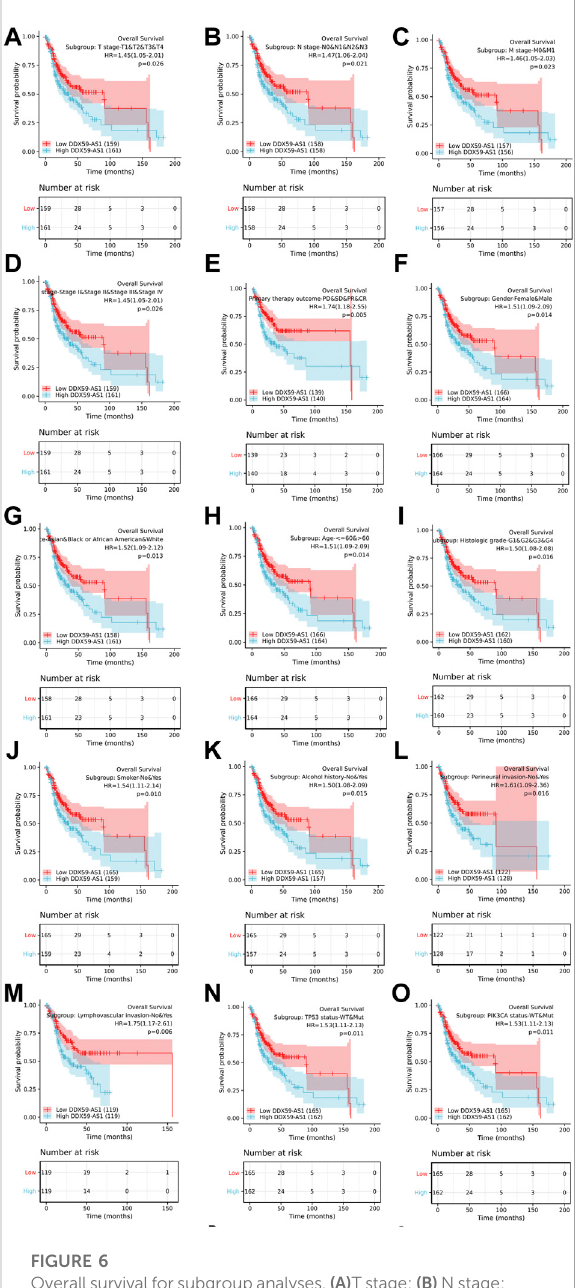
FIGURE 6 Overallsurvivalforsubgroupanalyses. (A) Tstage; (B) Nstage; (C) M stage; (D) Clinical stage; (E) Primary therapy outcome; (F) Gender; (G) Race; (H) Age; (I) Histologic grade; (J) Smoker; (K) Alcohol; (L) Perineural invasion; (M) Lymph vascular invasion; (N) TP53 status; (O) PIK3CA